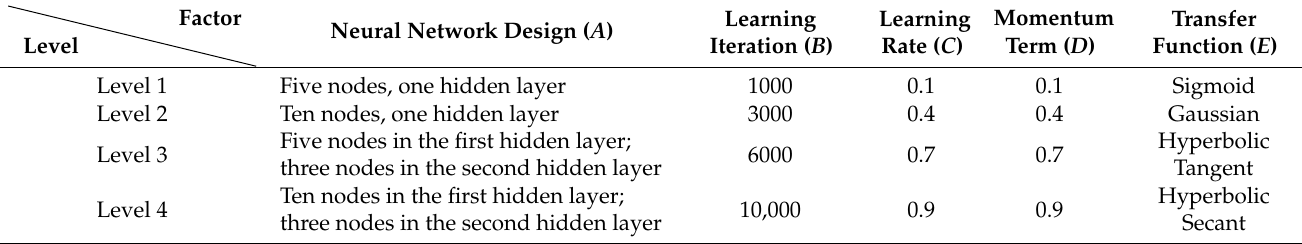
Table 7. Distribution list of the levels of factors of the neural